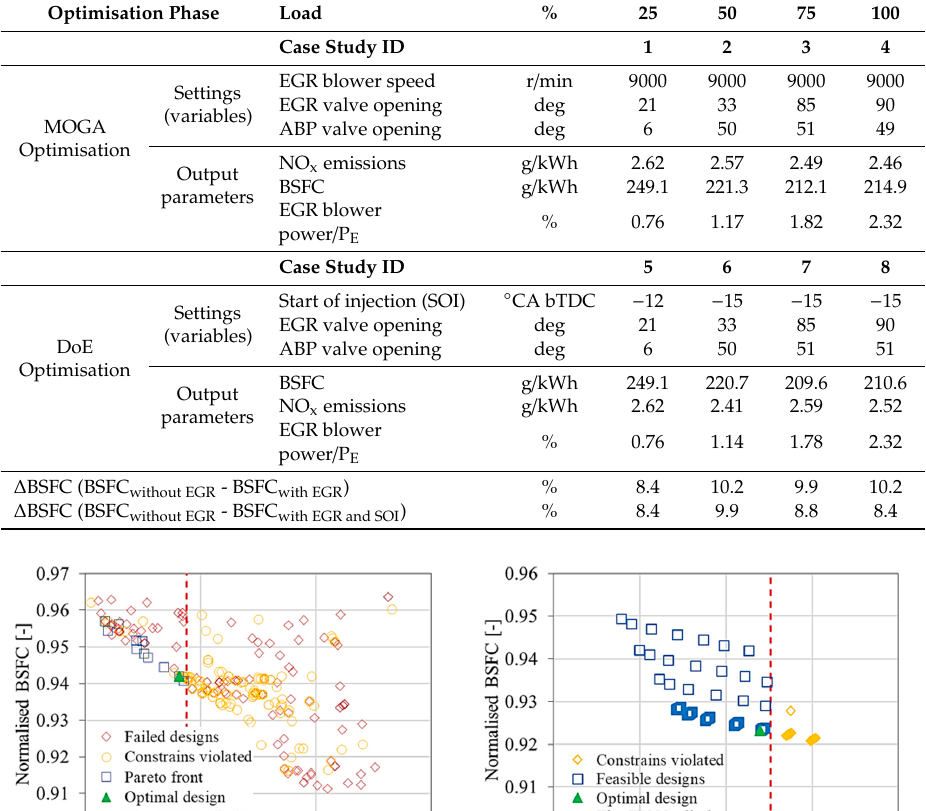
Table 5. EGR and ABP systems optimisation results summary (case studies 1–4 and 5–8).